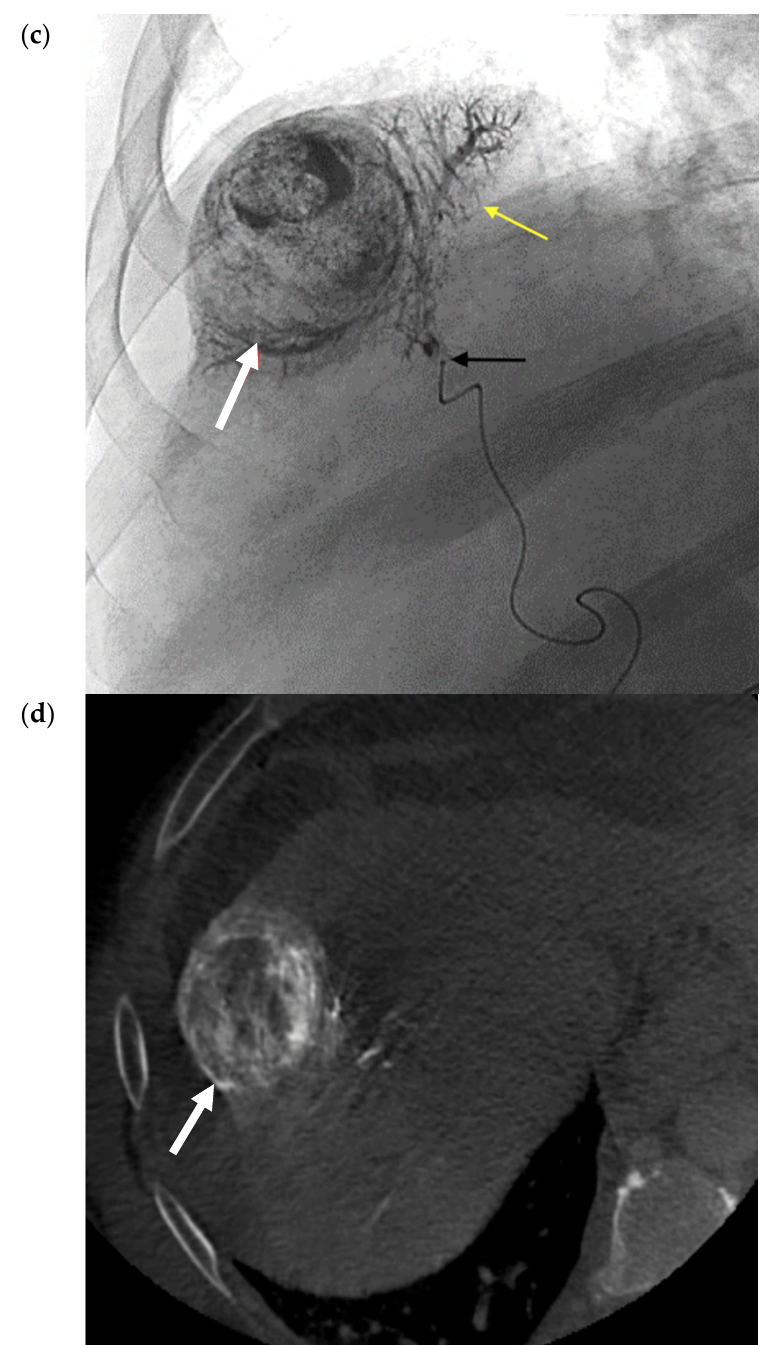
Figure 3. Conventional TACE (cTACE) for Solitary HCC. ( a ) Pre-procedure multiphasic MRI with contrast in the hepatic arterial phase. Hyper-enhancing mass (white arrow) in hepatic segment 8, consistent with HCC. ( b ). Digital subtraction angiogram of the right hepatic artery pre-embolization. Mass (white arrow) is supplied by the segment 8 branch of the right hepatic artery (black arrow). ( c ) Static fluoroscopic image of the treated segment 8 mass post-chemoembolization. Complete embolization of the mass (white arrow) with a diffuse retention of lipiodol after embolization via the right hepatic artery (black arrow). There is lipiodol staining of the portal vein, which is a therapeutic endpoint in conventional trans-arterial chemoembolization (TACE) (yellow arrow). ( d ) Intra-procedural noncontrast cone-beam CT immediately post-chemoembolization. Diffuse circumferential retention of lipiodol in the treated tumor confirms complete tumor treatment (red arrow).